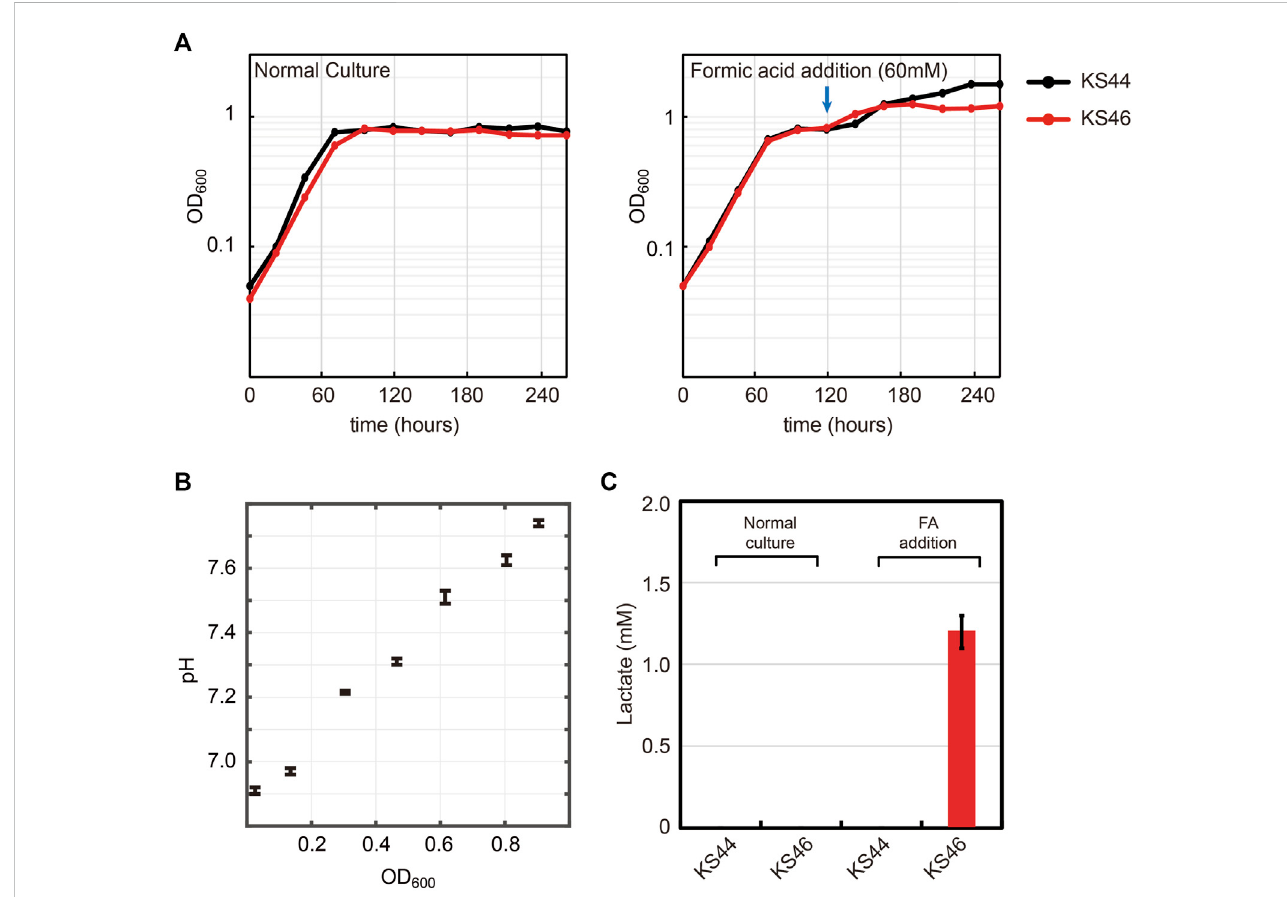
FIGURE 5 Lactateproductionfromformatewithformatotrophic E.coli . (A) Engineered E.coli strainwasculturedinminimalmediumusing90 mMformateand10% CO 2 as carbon sources. Two differentcultivation methods weretested: normalbatch mode and fed-batch modewith the addition of 60 mM formic acid (FA) at the indicated time point. (B) pH pro fi le during growth on formate. Cell growth on formate directly correlates with increased medium pH due to the accumulation of OH − . (C) Lactate production was observed only with the strain in the fed-batch mode along with ldhA overexpression (n = 4, lactate measurement was conducted at the end of cultivation). Experiments were carried out at 10% CO 2 in incubator shaker. Displayed results are averages with errors <